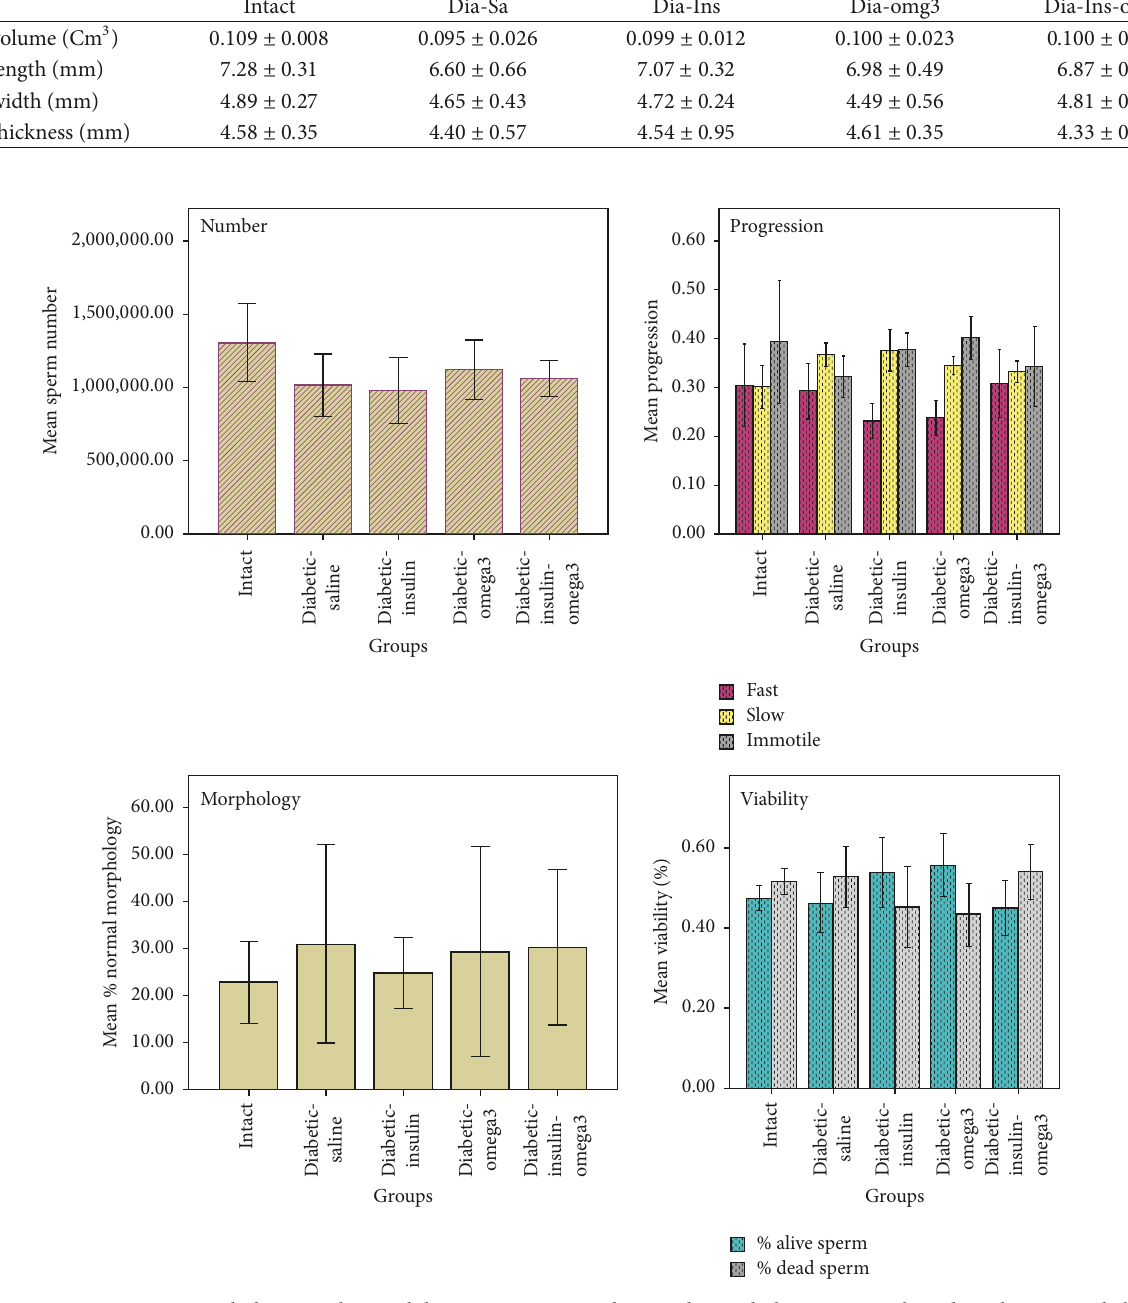
Figure 1: Sperm parameters including number, viability, progression, and normal morphology were evaluated in the intact, diabetic- saline (Dia-Sa), diabetic-insulin (Dia-Ins), diabetic-omega3 (Dia-omg3), and diabetic-insulin-omega3 (Dia-Ins-omg3) groups. There was no statistically significant difference among the